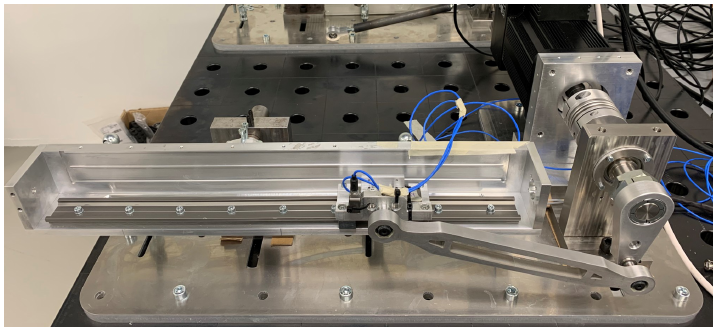
Figure 3. The slider-crank: experimental setup.